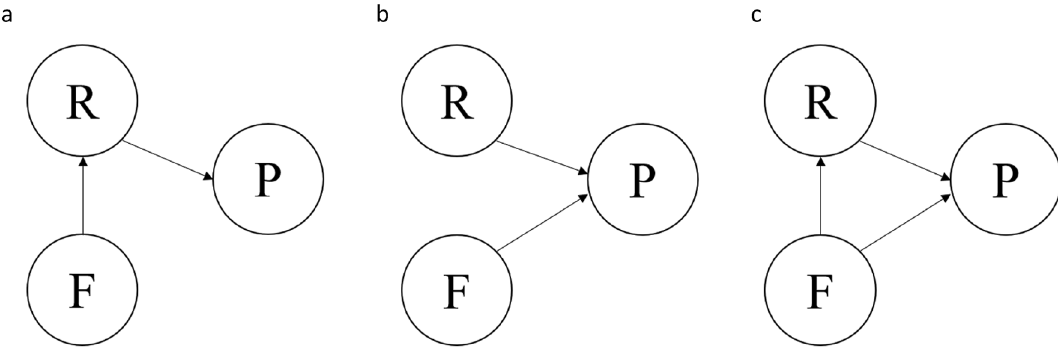
Figure 1. Conceptual diagrams for ( a ) Model 1, ( b ) Model 2 and ( c ) Model 3, where F represents farm characteristics, R represents respiratory prevalence and P represents production outcomes. The arrows indicate the direction of the